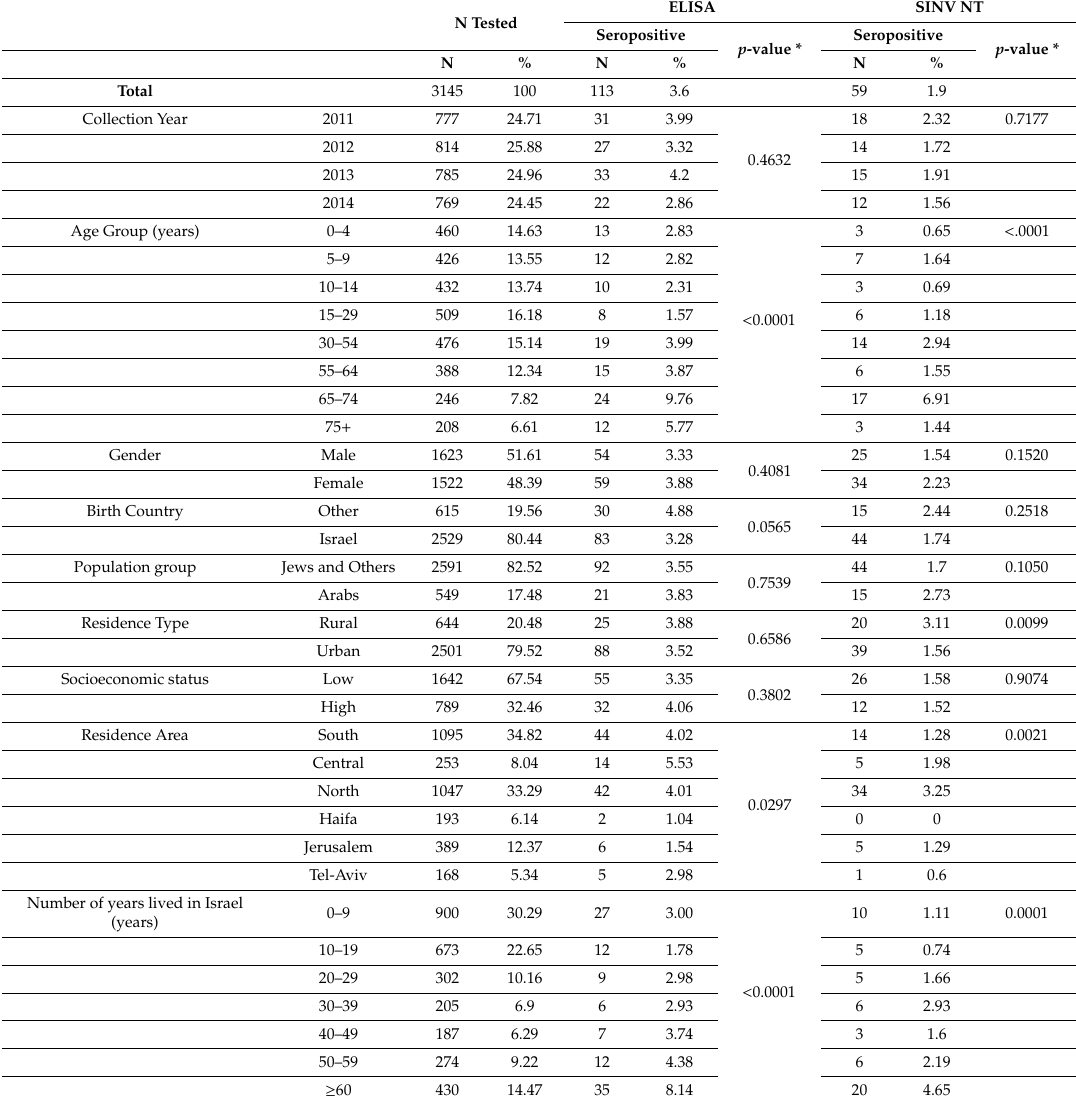
Table 1. Demographic characteristics of the study population ( N = 3145). SINV NT: Sindbis virus